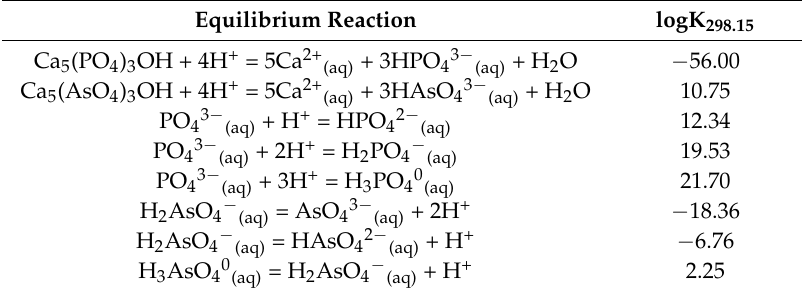
Figure 8. Evolution of solution composition and pH with time during the 119-day dissolution of JBM–HAP solid solution series at 5, 25, 45, and 65 °C and at an initial pH of 4.50. Table 3. Selected ionic speciation reactions and equilibrium constants (logK 298.15 ) resulting from dissolution of the solid solution series